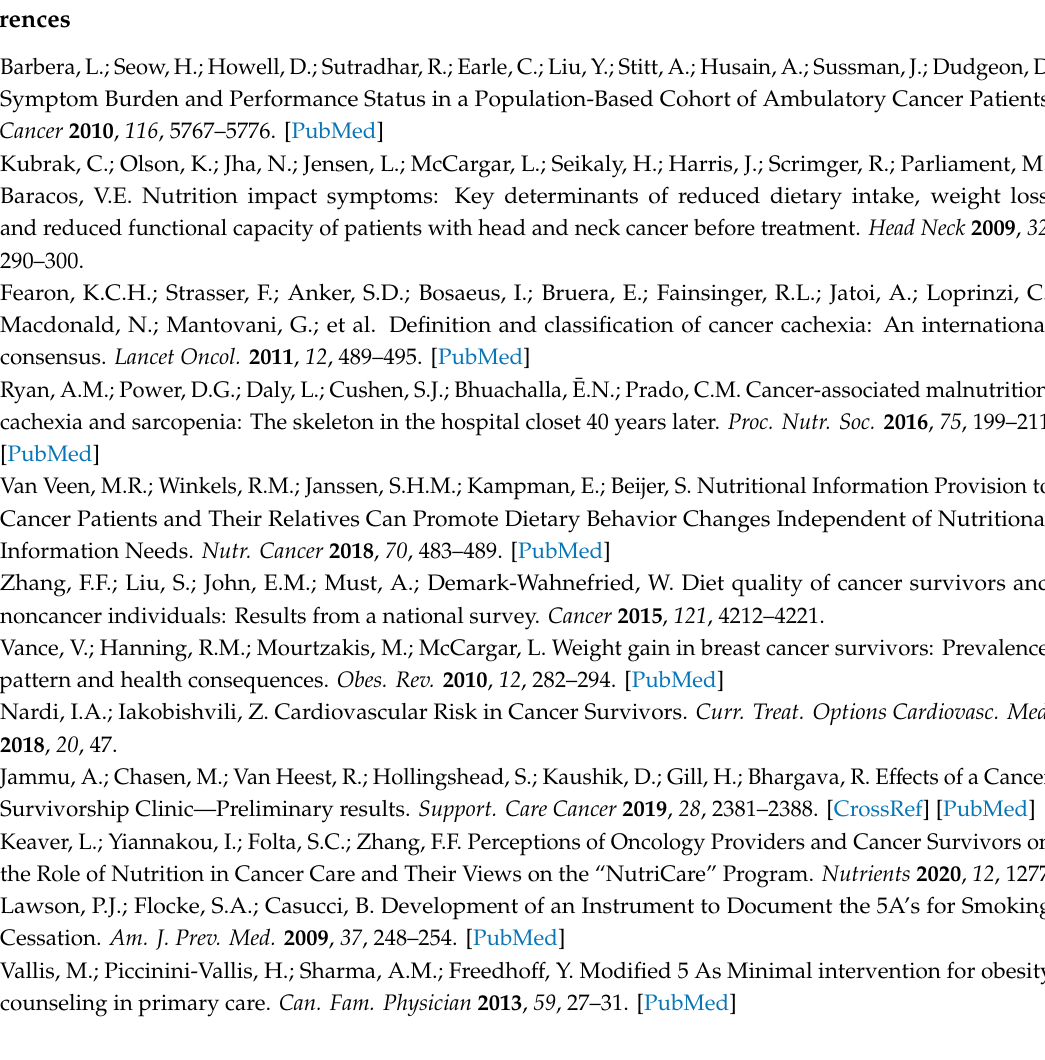
Table S1: Additional participant characteristics; Table S2: Results of the NACP questionnaire ( n = 20), at